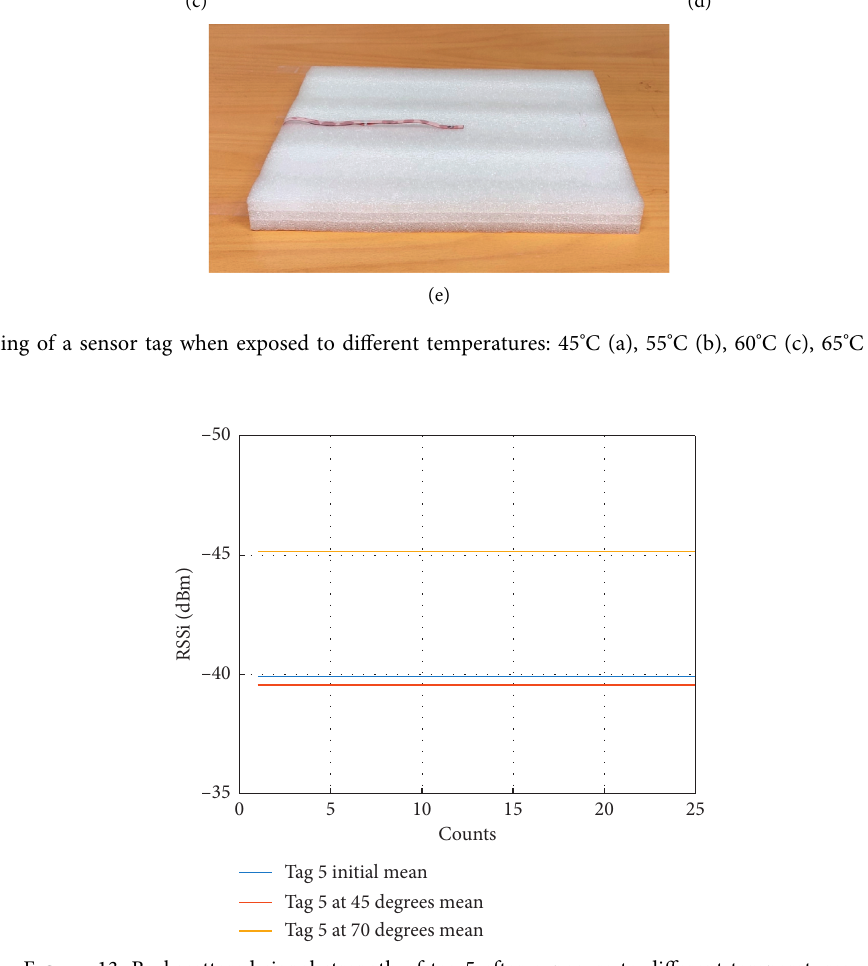
Figure 13: Backscattered signal strength of tag 5 after exposure to different temperatures.